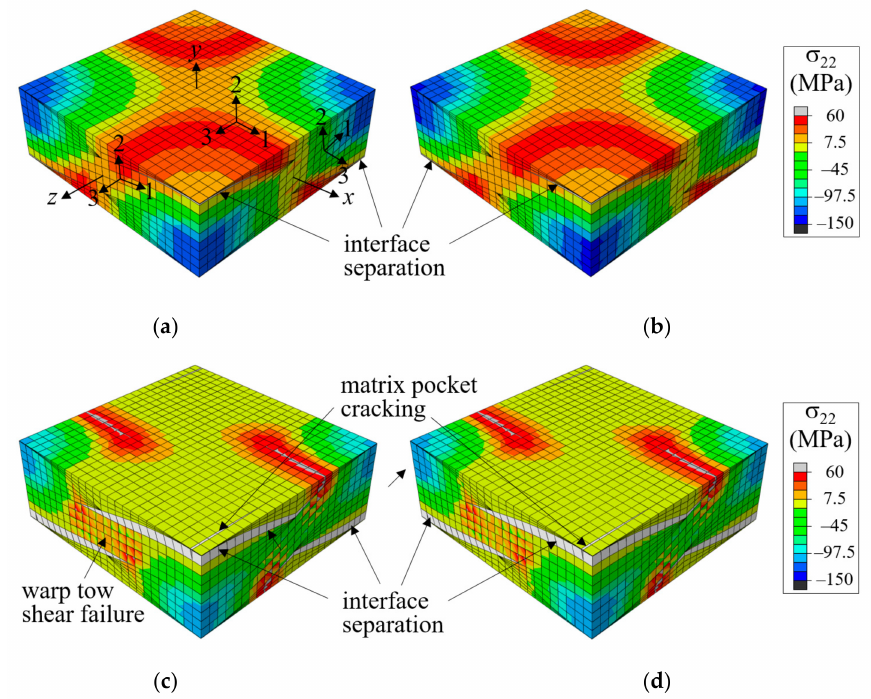
Figure 8. Comparison of σ 22 -stress and failure shapes of symmetric plain weave unit cell ( x = λ w /2) under tension in the x -direction: ( a ) CCZM at ˆ ε xx = 0.0101; ( b ) MCZM at ˆ ε xx = 0.0101; ( c ) CCZM at ˆ ε xx = 0.0102; and ( d ) MCZM at ˆ ε xx = 0.0102 (deformation scale factor = 2; xyz : global coordinates; 123: material coordinates).